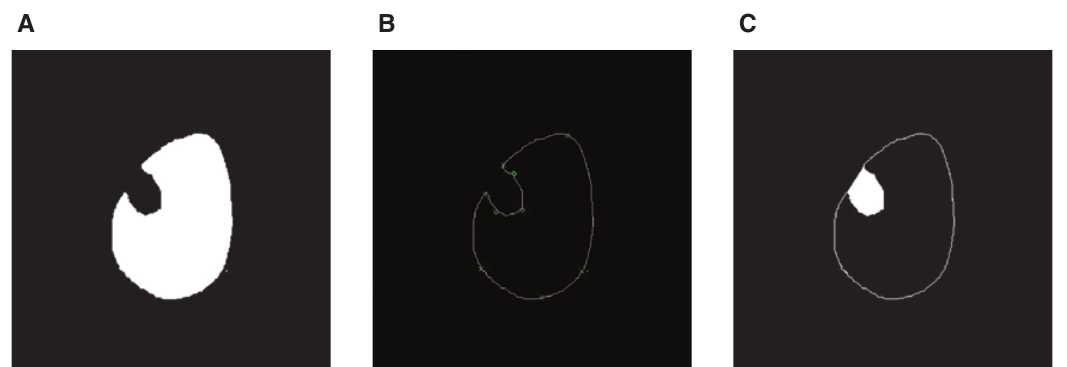
Figure 9: Structure Similar to Lung Lobes for Filling.